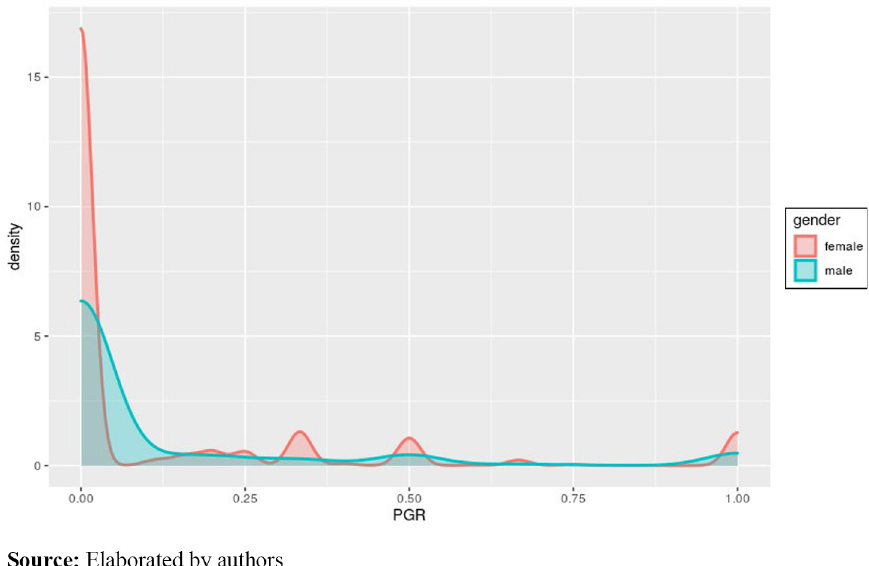
Figure 5. Proportion of gains realized by